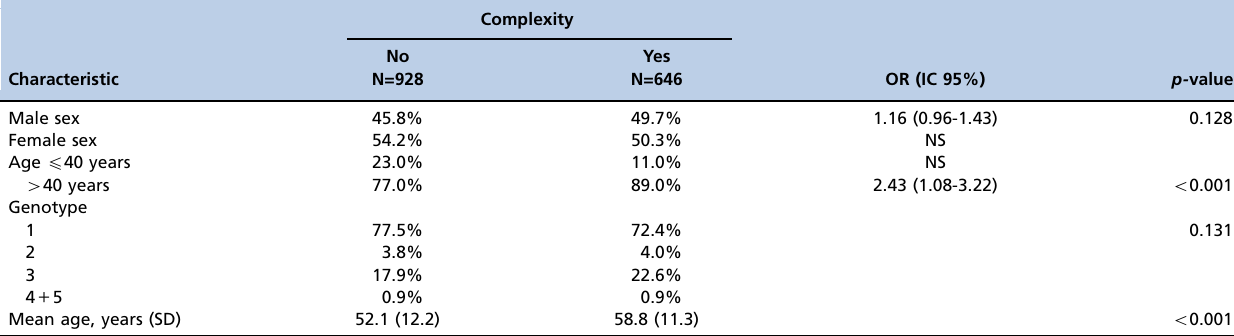
Table 2 - Demographic and clinical characteristics of patients according to the presence or absence of clinical